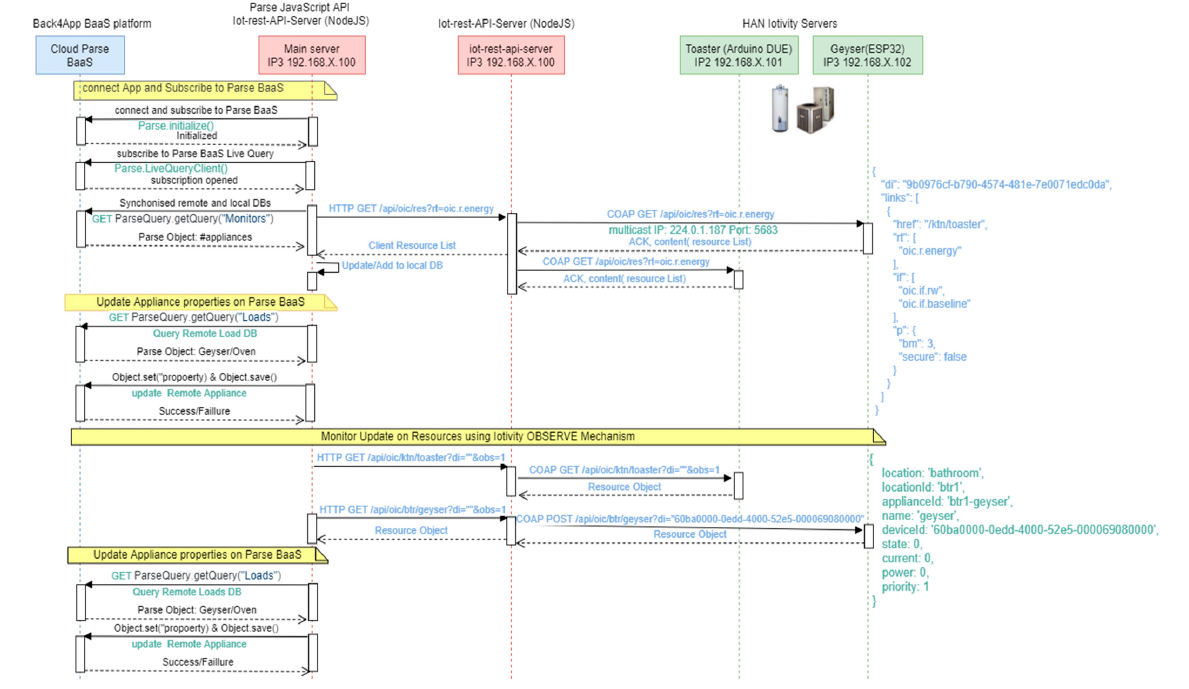
Figure 4. Local and cloud configuration and communication in the platform .